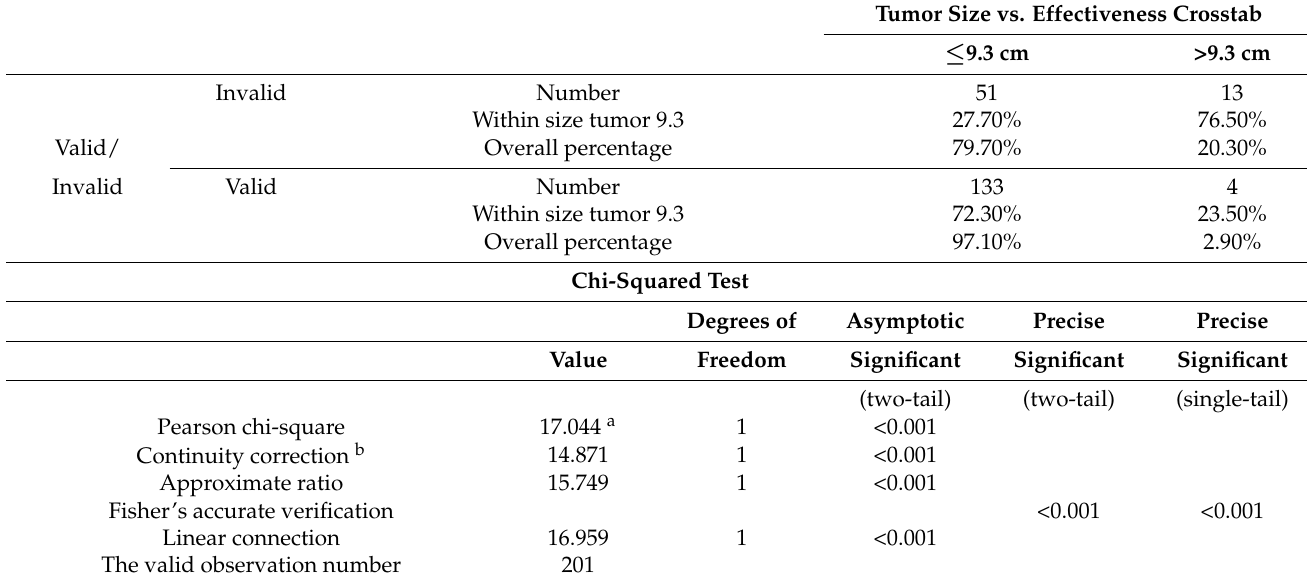
Table 4. T-test result, Tumor Size vs.